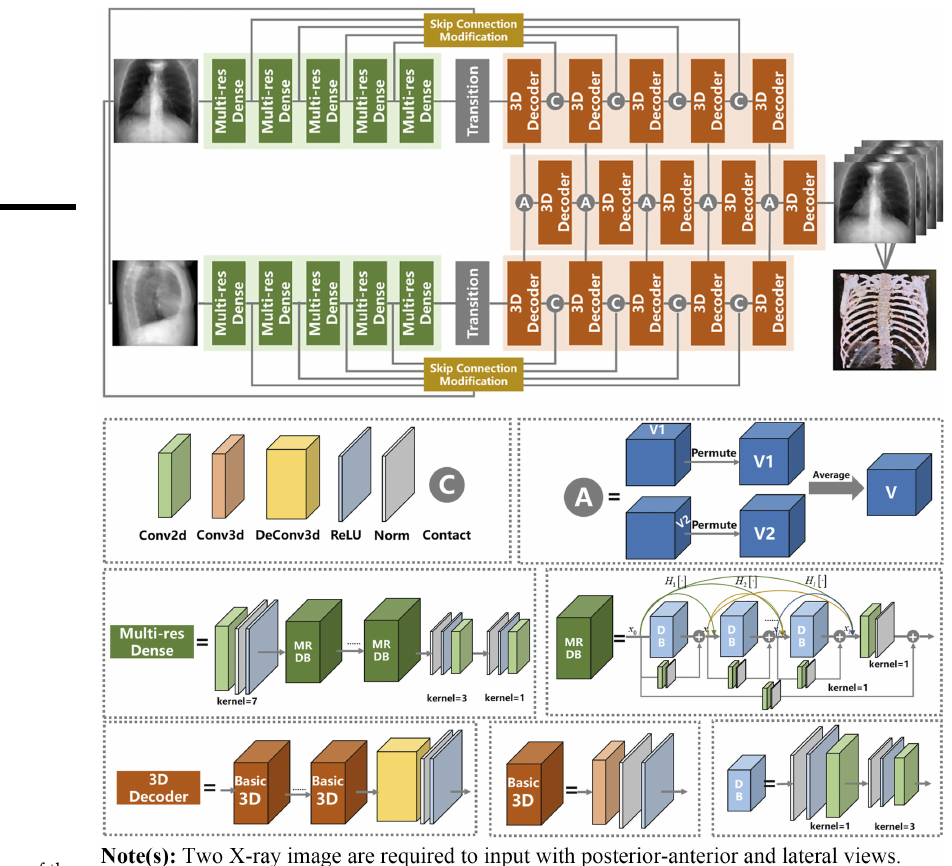
Figure 1. The architecture of the MFCT-GAN contains two parallel encoder- decoder